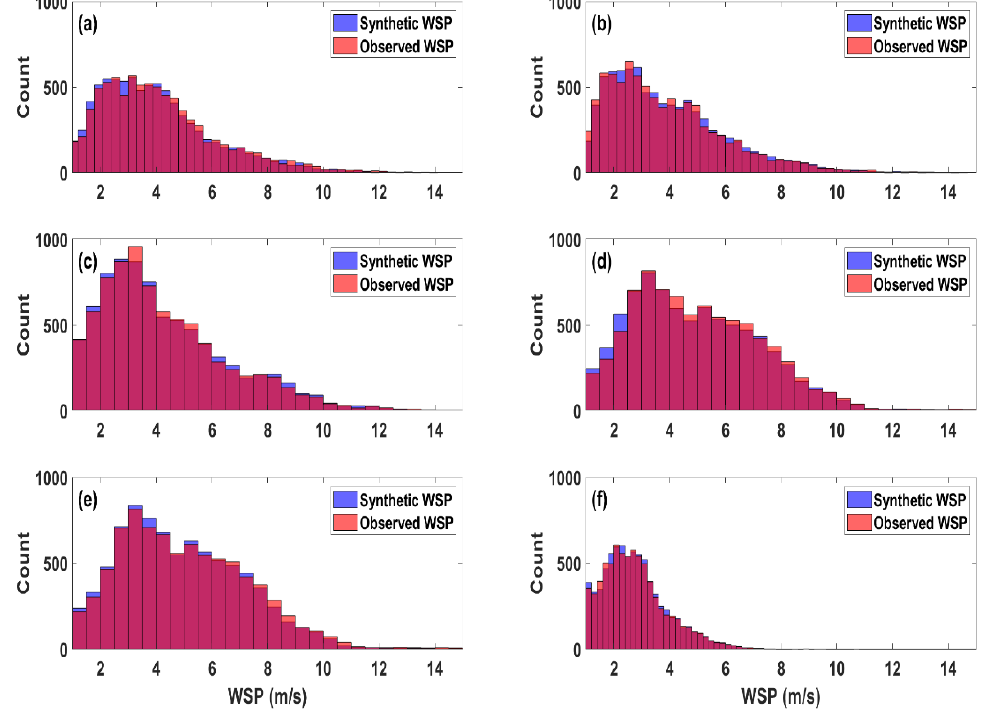
Figure 6. Histograms of LSTM-generated and NDBC-observed wind speed (m/s) or buoys ( a ) 42056, ( b ) 42057, ( c ) 42058, ( d ) 42059, ( e ) 41046, and ( f ) 41047.